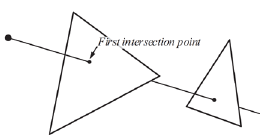
Figure 7 . Ray-triangle intersection (credits: Liu et al., 2019)